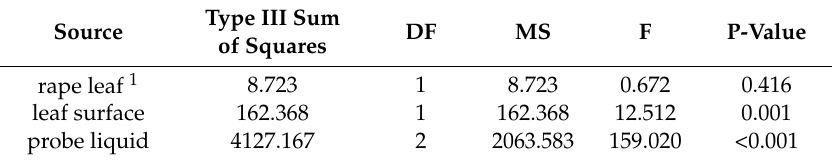
Table 5. Effect of rape leaf, leaf surface, and probe liquid on contact